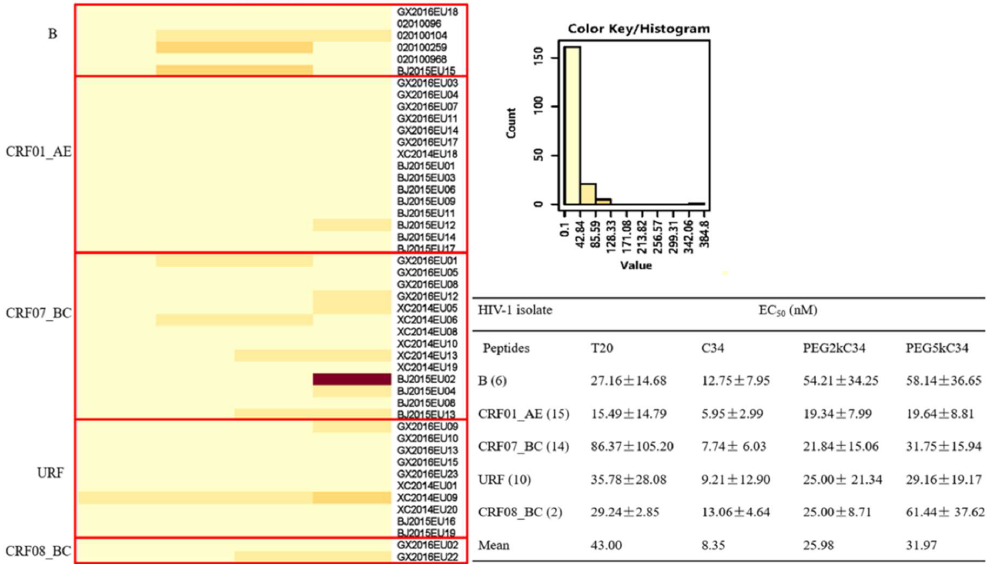
Figure 4. The infection inhibitory activities of T20, C34, PEG2kC34 and PEG5kC34 against 47 clinical isolates in TZM-bl cells. The 47 clinical isolates are B (6/47), CRF01_AE (15/47), CRF07_BC (14/47), URF (10/47) and CRF_08BC (2/47) subtypes. The heat map was constructed with the online software (HIV database). Low values tend towards yellow tones while higher values tend to hotter orange and red